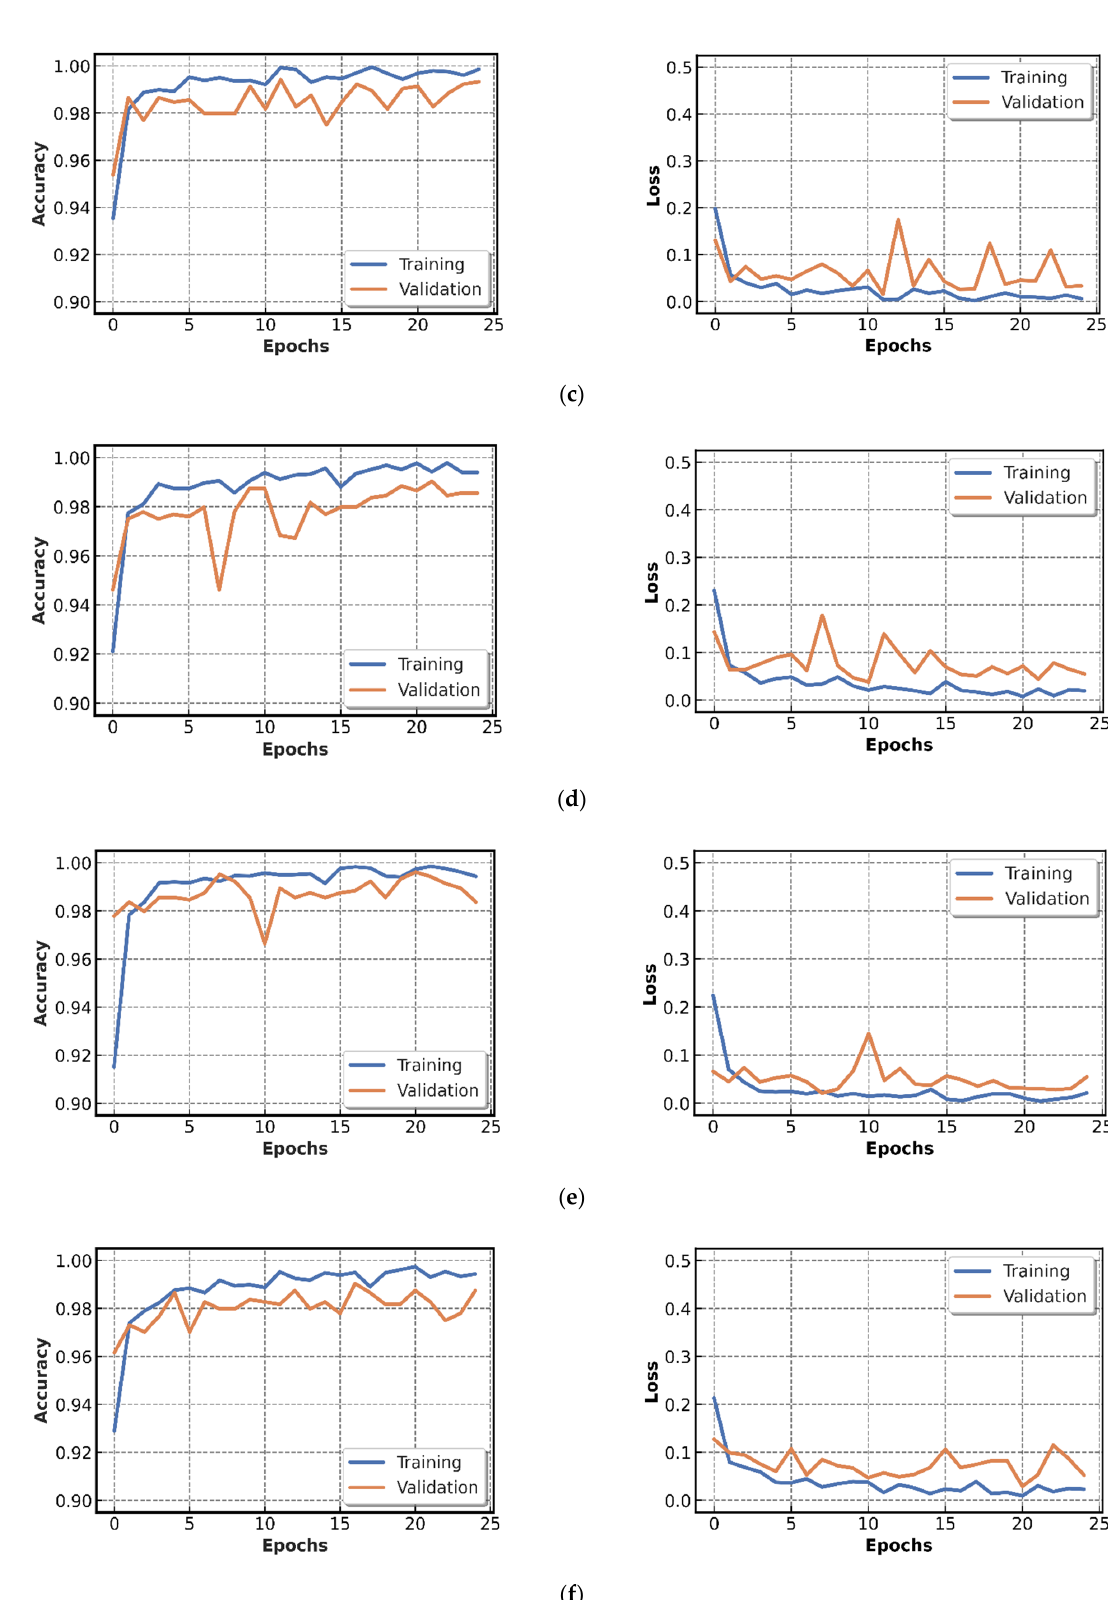
Figure 5. The accuracy and Loss of all modified pre-trained models. ( a ) Xception model, ( b ) Inception V3 model, ( c ) InceptionResNet V2 model, ( d ) ResNet50 V2 model, ( e ) MobileNet V2 model, ( f ) Dense- Net201